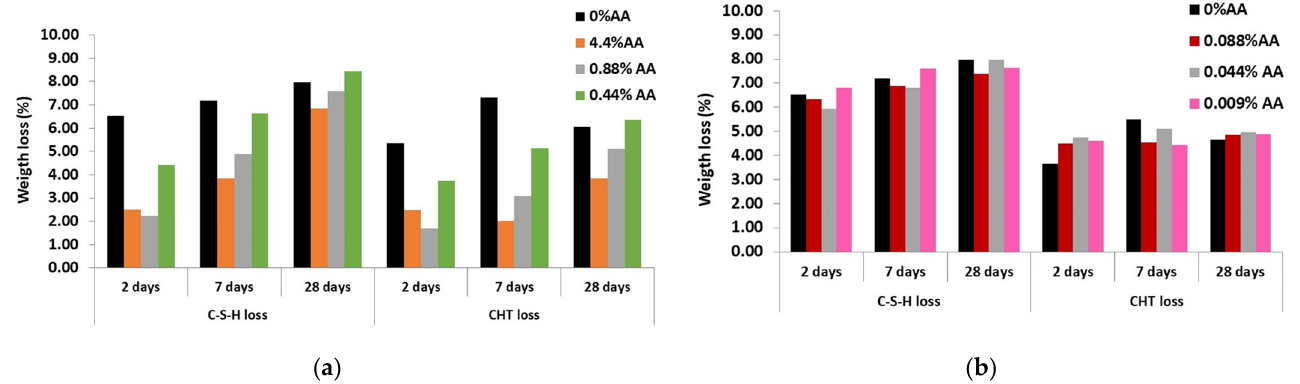
Figure 9. Weigth loss (wt.%) of cement pastes with AA ( a ) 4.4, 0.88 and 0.44% of AA; ( b ) 0.088, 0.044, 0.009% of AA.